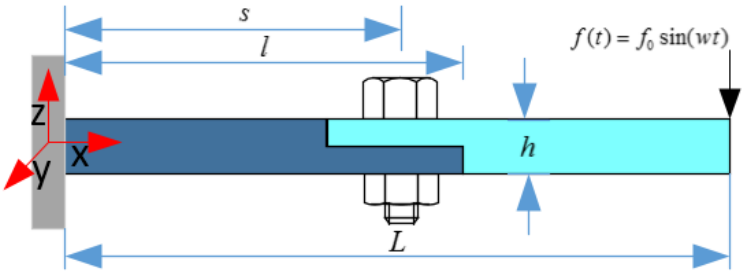
Figure 1. Structural diagram of bolted cantilever beam.